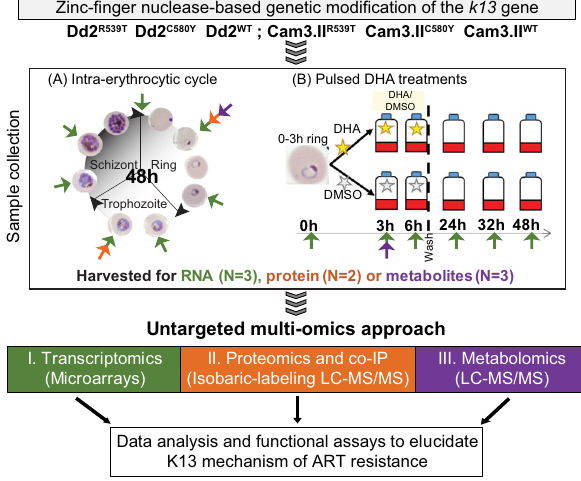
Fig. 1 Outline of experimental work fl ow and multi-omics